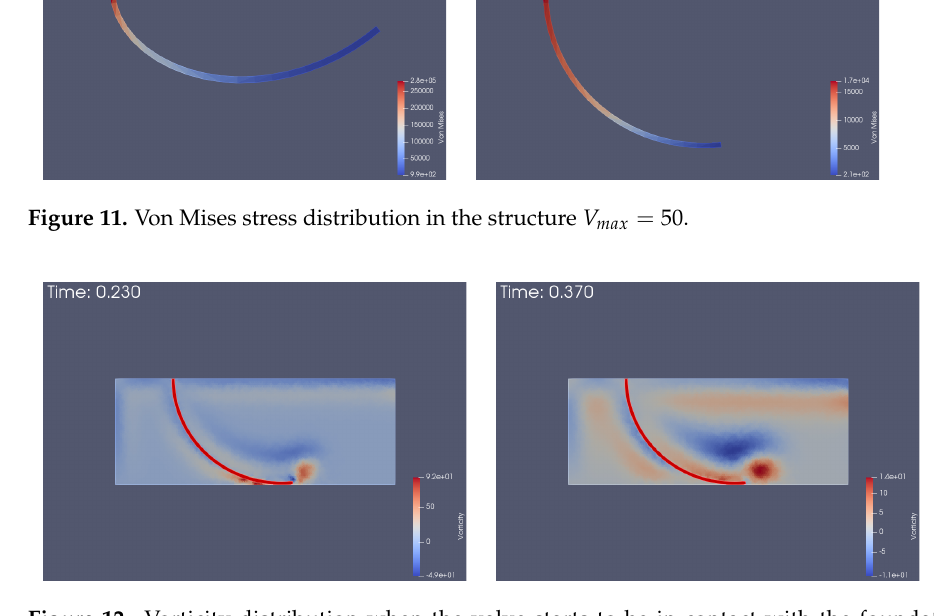
Figure 12. Vorticity distribution when the valve starts to be in contact with the foundation for V max = 10 ( left ) and V max = 50 ( right